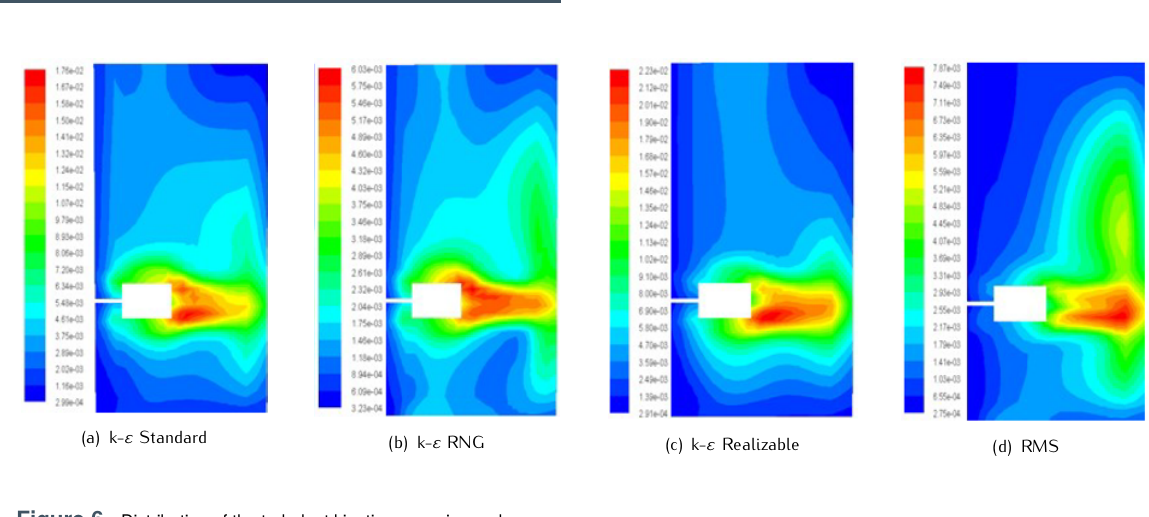
Figure 6. Distribution of the turbulent kinetic energy in r-z plane.